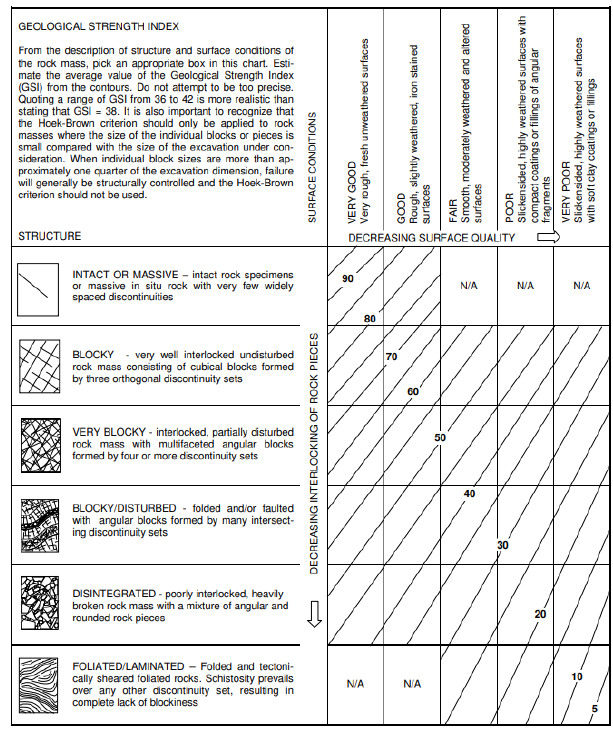
Figure A3. GSI chart for jointed rock masses [23].